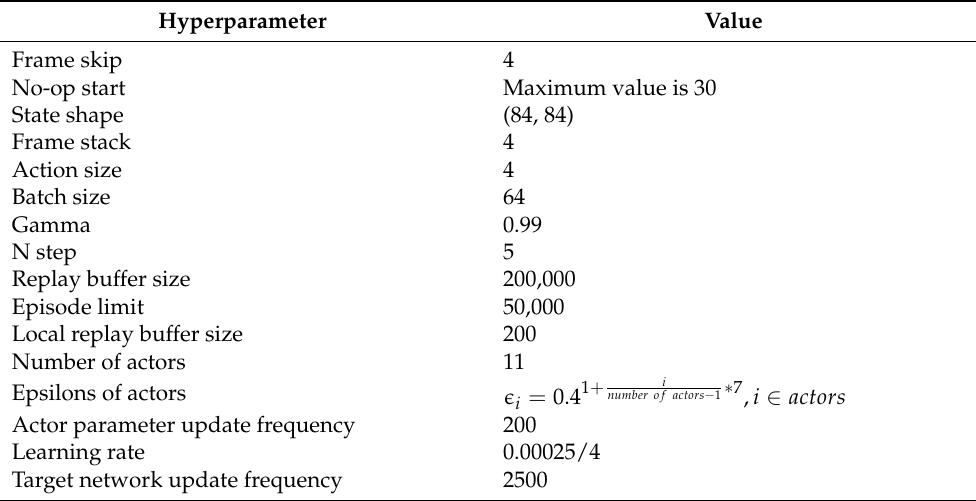
Table 4. Hyperparameters in deep reinforcement learning Ape-x